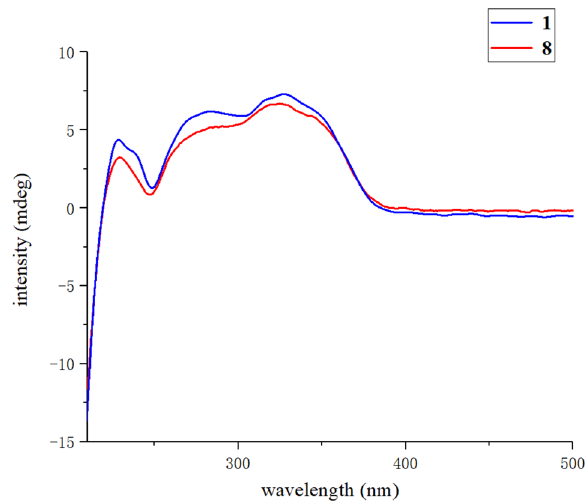
Fig. 4 Experimental ECD spectra of 1 and 8